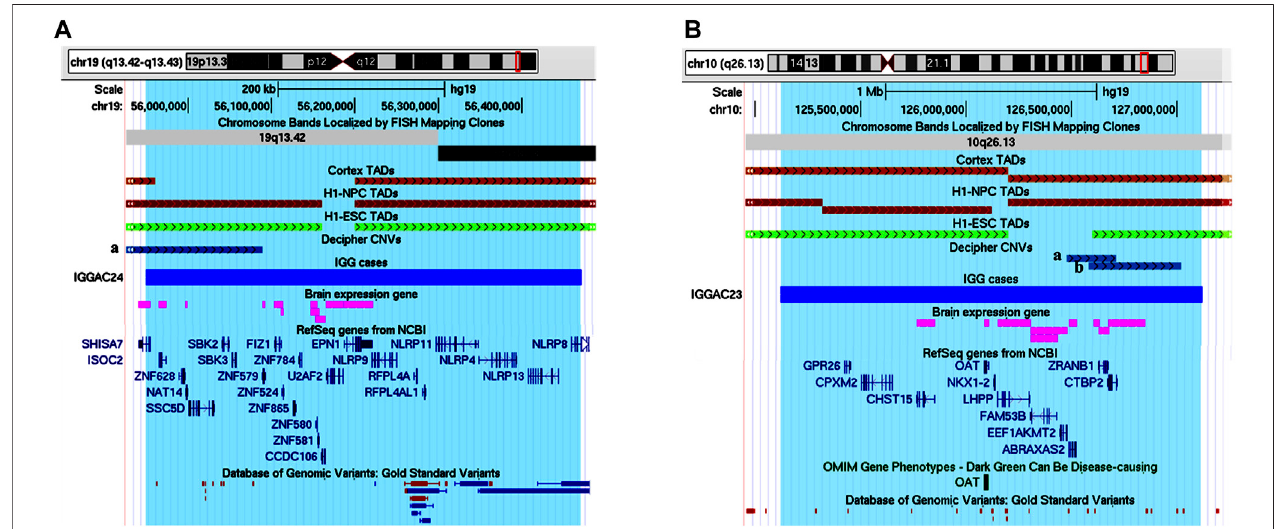
FIGURE9| Duplications oftopologicaldomain boundaries(TDBs)potentiallyinvolvedinthephenotype ofpatientIGGAC24 and patientIGGAC23. (A) Screenshot of chromosome 19 region encompassing the duplication of patient IGGAC24 (blue bar, chr19:55,948,706-56,471,996). TADs from Cortex, H1NPC and h-ESC cells. Brain-expressed genes (see Methods ). Decipher patient with reported duplication (a. patient 338729) (B) Screenshot of chromosome 10 region encompassing the duplication of patient IGGAC23 (blue bar, chr10:125,121,038-127,119,447). Brain-expressed genes (see Methods ). Decipher patients with reported duplications (a: patient 283429, b: patient